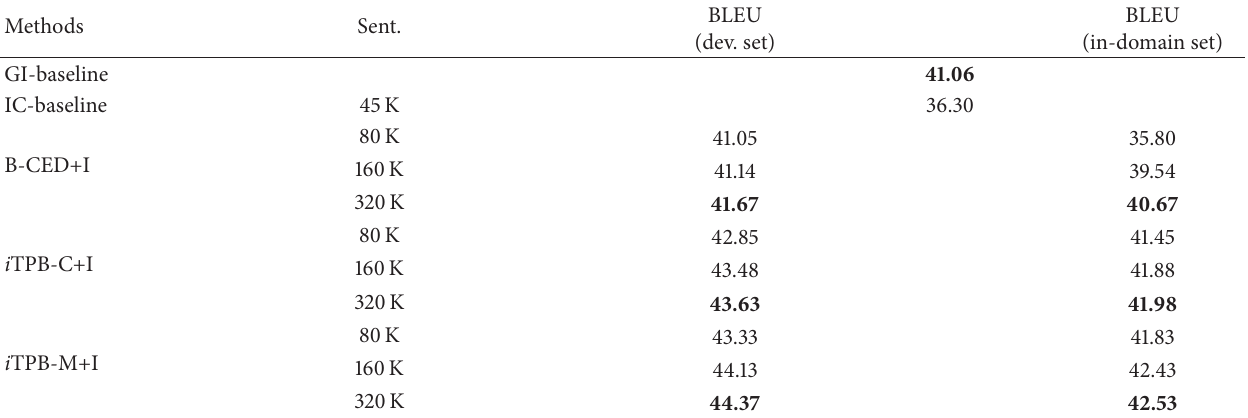
Table 5: Results of combination